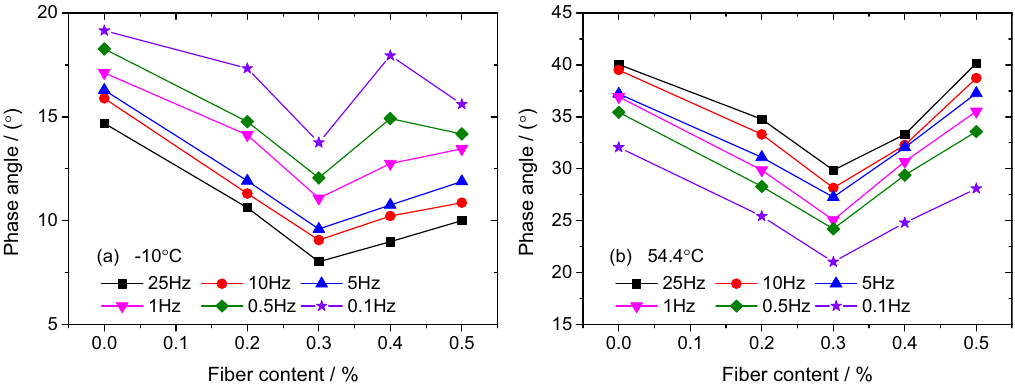
Figure 7: Variation of phase angles of AC mixtures with basalt fi ber contents at ( a ) − 10°C and ( b ) 54.4°C.